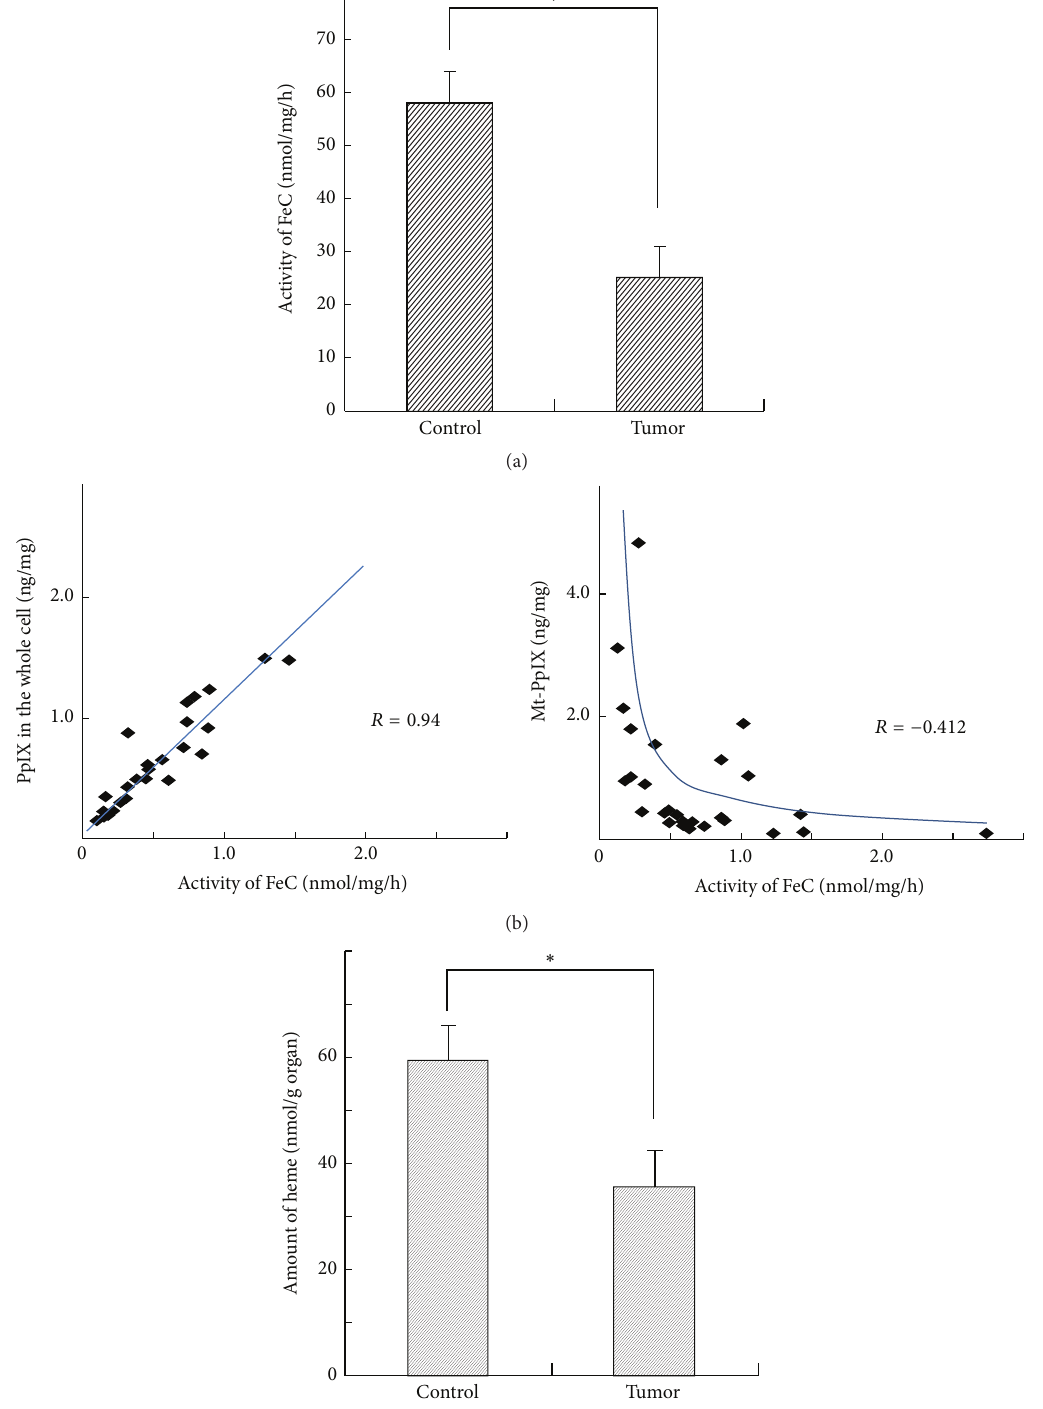
Figure 3: (a) Ferrochelatase (FeC) activity. Note that the FeC activity clearly decreased more in the malignant glioma cells ( 𝑛 = 28 ) than in the control cells ( 𝑛 = 14 ) ( ∗ 𝑝 < 0.01 ). The FeC activity is expressed by the amount of heme biosynthesized from PpIX per unit time. Namely, the unit of FeC activity is nmol of heme formed/mg/organ/h. The unit of PpIX is nmol/g/organ. (b) The correlation between the FeC activity and the amount of PpIX in the mitochondria or in the whole cell. The left panel shows the relationship between the total intracellular amount of PpIX and the FeC activity. The right panel shows the relationship between the amount of PpIX in the mitochondria and the FeC activity. Note that the FeC activity and the total amount of PpIX were positively correlated ( 𝑅 = 0.94 ). The FeC activity and the amount of PpIX in the mitochondria were negatively correlated ( 𝑅 = −0.412 ). Namely, the FeC activity decreased with an increase in the accumulated amount of PpIX in the mitochondria. (c) The amount of heme in the mitochondria. The amount of heme in the mitochondria was compared between the control cells ( 𝑛 = 14 ) and tumor cells ( 𝑛 = 28 ). This amount was remarkably smaller in the tumor tissue than in the normal tissue ( ∗ 𝑝 < 0.01